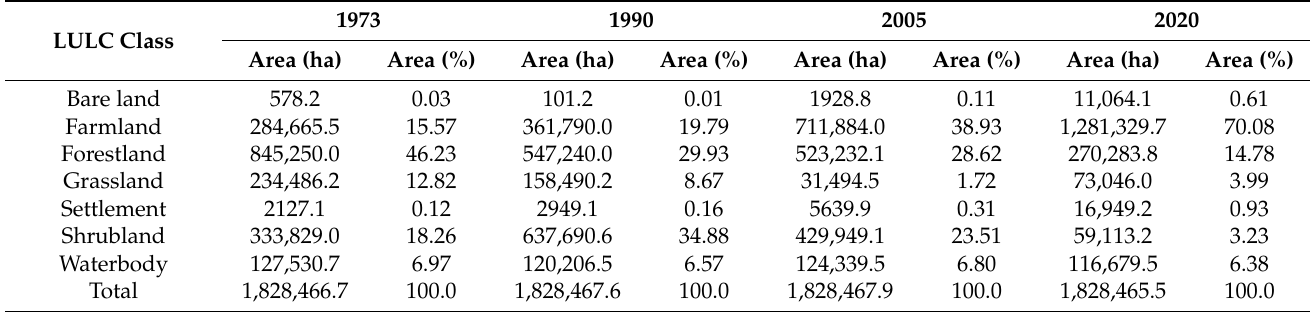
Table 5. Area coverage of major land use and land cover types.